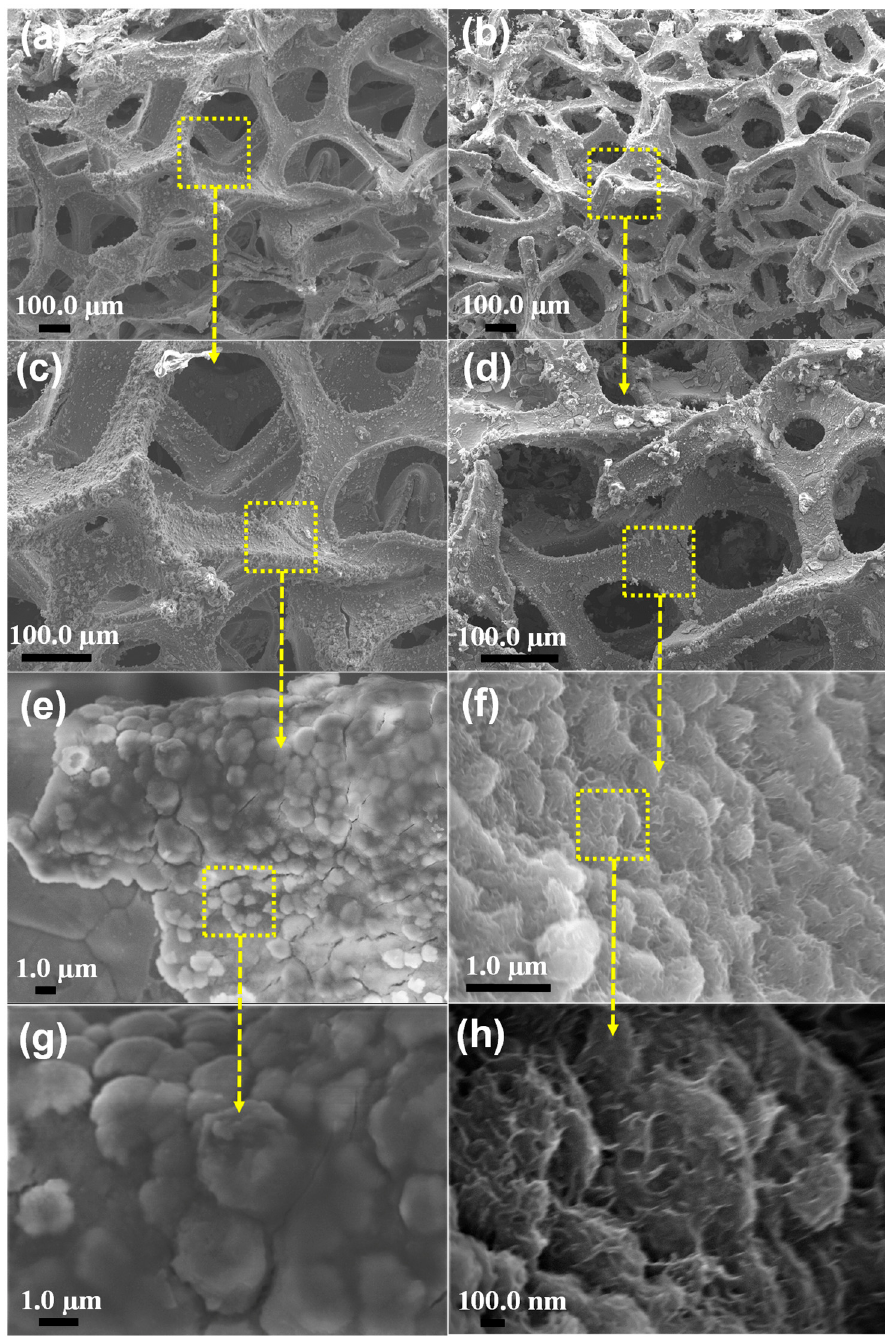
Figure 3. ( a , c , e , g ) FESEM images of the NiS-3D-Nf electrode at different magnifications and ( b , d , f , h ) FESEM images of the w-NiS-3D-Nf electrode at different magnifications.